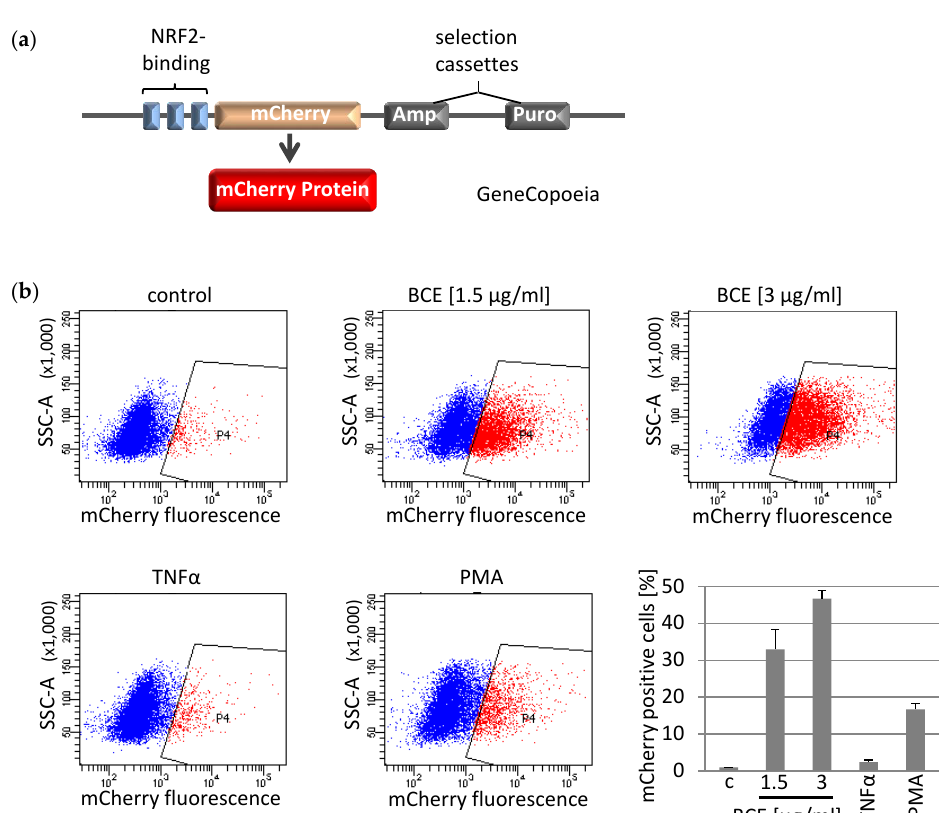
Figure 4. Bread crust extract (BCE) induces the transcription factor NRF2 in EA.hy926 cells. ( a ) Schematic of the reporter plasmid transfected in EA.hy926 cells. The NRF2 binding sites, antiox- idant response elements (ARE) are shown as blue rectangles. The activated fluorescence reporter gene, mCherry is highlighted in orange and its protein product is depicted in red. Selection cassettes (puromycin and ampicillin) are illustrated as grey boxes. ( b ) Induction of mCherry protein expression in transfected EA.hy926 cells evaluated by flow cytometry. The scatter plot graph indicates the cell scatter on the y -axis vs. the PE-Texas Red-A filter (mCherry fluorescence) on the x -axis measured on a BD Fortessa device and using the Diva software (BD-biosciences). As indicated, untreated reporter cells (control), cells treated with BCE (1.5 µ g/mL; 3 µ g/mL), cells treated with TNF α (15 ng/mL) or PMA (20 ng/mL) for 24h are shown. The percentage of mCherry positive cells was determined in three independent